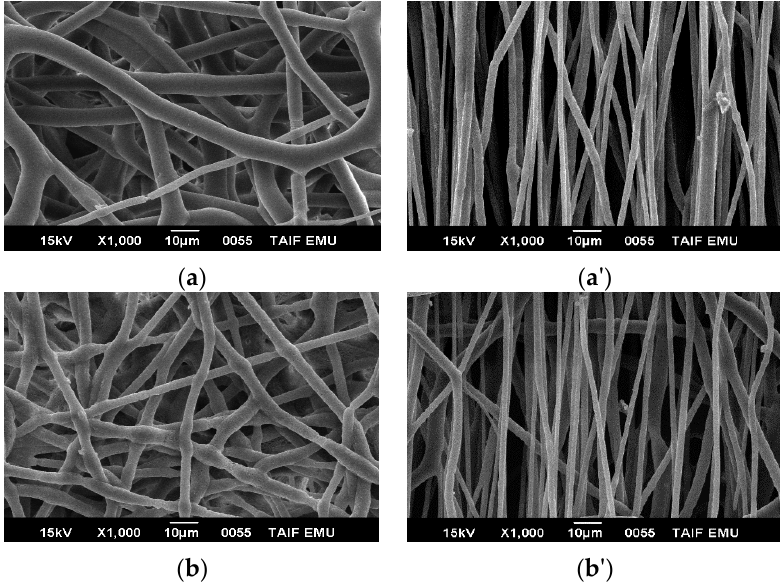
Figure 1. The samples of pure PHB and blend 1 were collected on the aluminum foil with the following die diameter, applied voltages, CF/DCM ratios, flow rate, and the distance between needle and target: 20 wt %, 1.3 mm, 20 kV, 75:25, 0.185 µm ⋅ h − 1 , and 20 cm, respectively; ( a , a' ) pure PHB at a fixed target (random) and rotating drum with a speed of 1100 rpm with polymer concentrations of 20%; ( b , b' ) blend 1 at a fixed target (random) and at a rotating drum with a speed 1100 rpm with polymer concentrations of 25%.